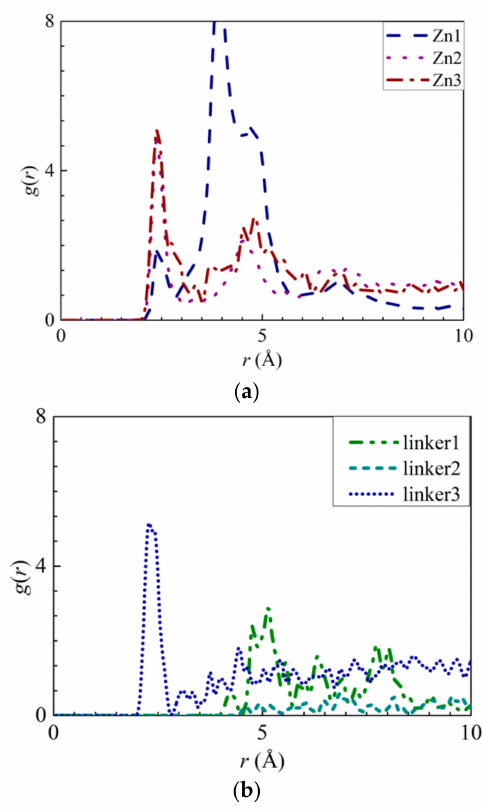
Figure 7. RDFs of the Cl − ions around the atoms from the respective ZIFs: ( a ) H3 atoms at the Zn substitutional defect site and ( b ) H3 atoms at the linker substitutional defect site,